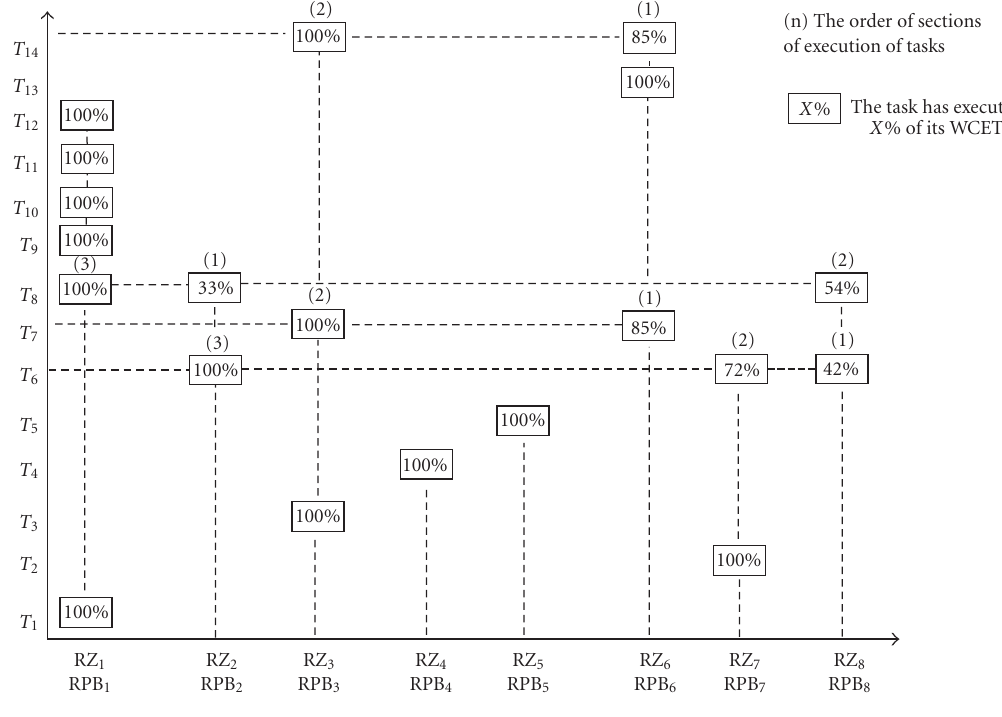
Figure 8: Resolution of fitting tasks on RZs.